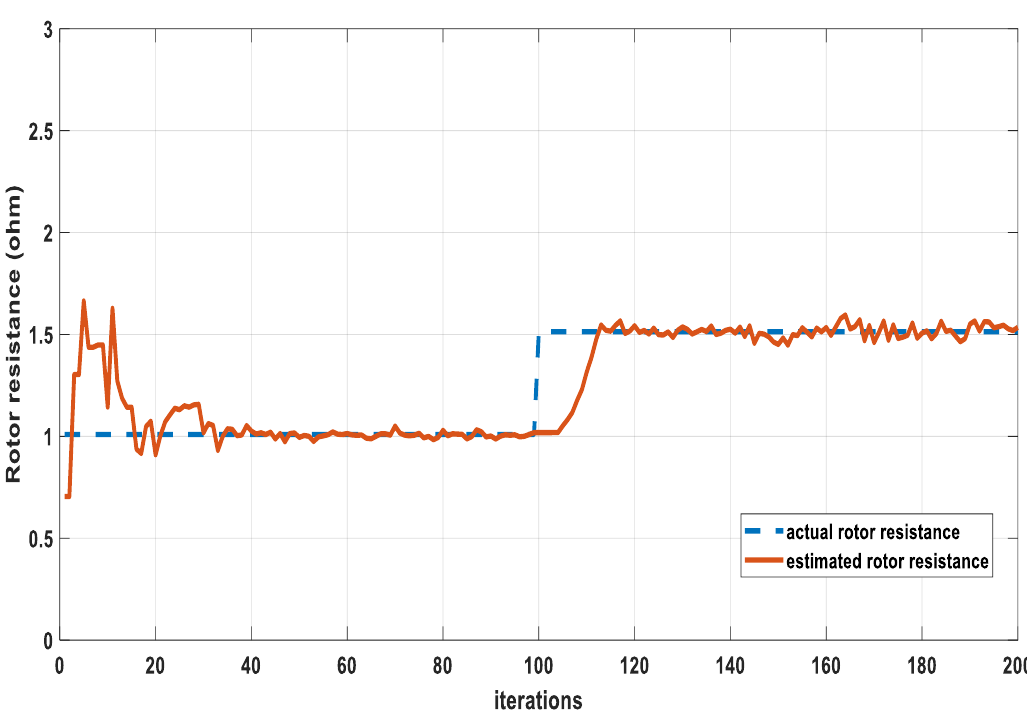
Figure 6. Rotor resistance versus iteration numbers.